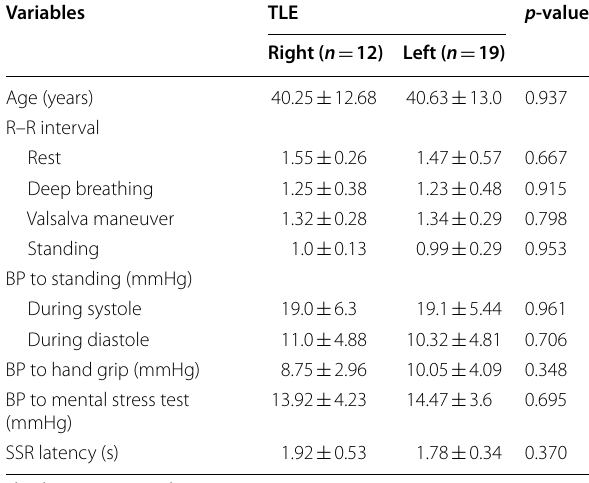
Table 4 Autonomic function tests in